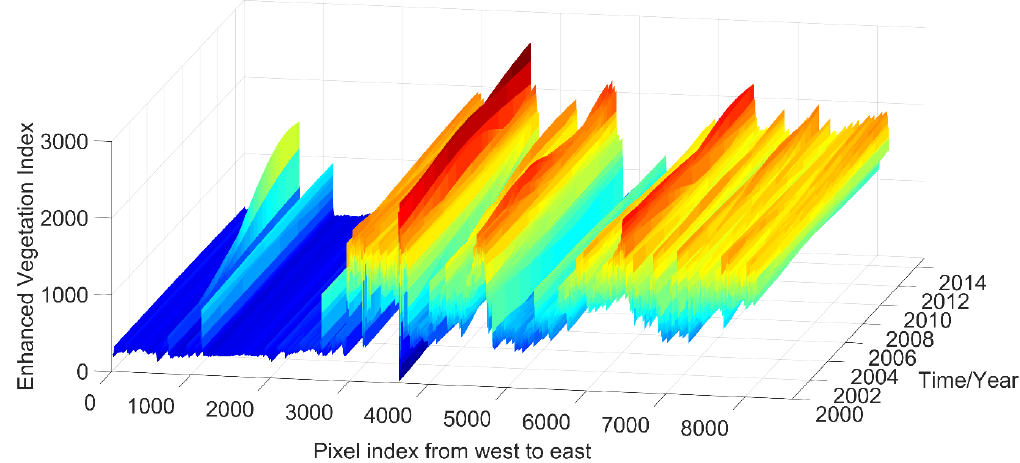
Figure 4. EVI residuals displayed in spatial and temporal surface.